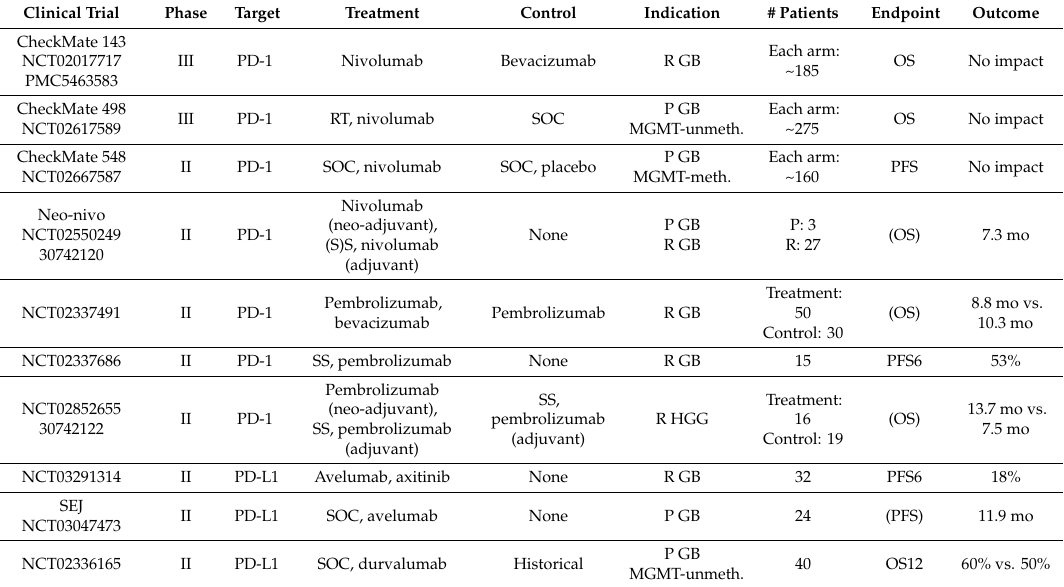
Table 1. Phase II / III clinical trials with immune checkpoint inhibitors in